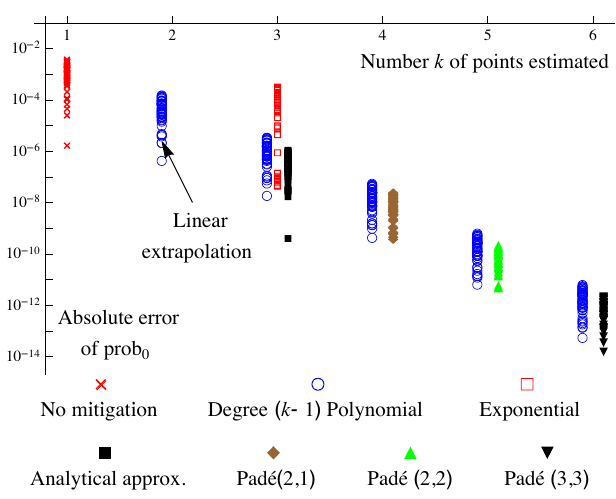
FIG. 3. Mitigating errors in the derangement operator. Extrapo- lation errors using various different fitting techniques versus the number of fitting points for 50 randomly selected Ansatz states. Elementary gates in the derangement operator in Fig. 1 have an error rate ϵ ¼ 10 − 3 and an experimentalist can increase this error in k ¼ 2 ; 3 ; 4 ; … steps up to ϵ ¼ 10 − 2 . The probability prob 0 from Fig. 1 at ϵ ¼ 0 is estimated by extrapolating to ϵ ¼ 0 . The derangement measurement is highly resilient to imperfections (see text) and prob 0 ð ϵ Þ is almost linear in ϵ . Increasing the degree of the fitting polynomial (blue circles) reduces the extrapolation error